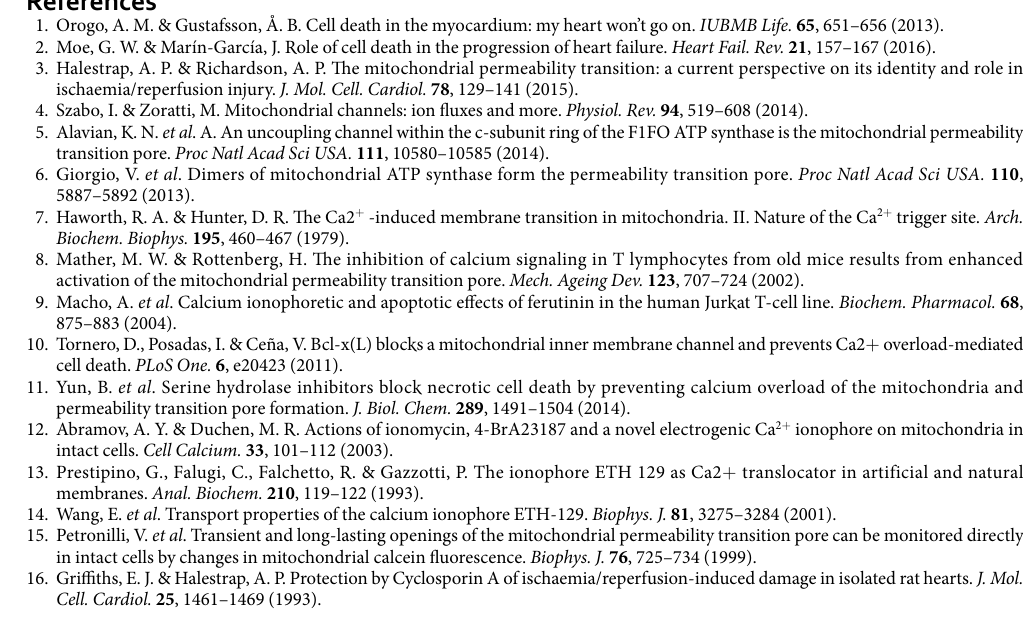
10 Scientific RepoRts | 7: 4283 | DOI:10.1038/s41598-017-04618-4